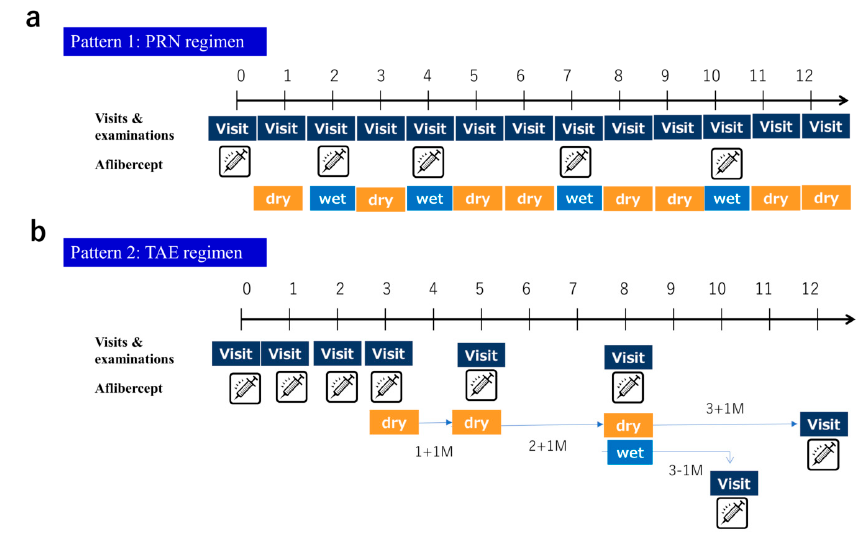
Figure 2. Example of the administration method of the pro re nata (PRN) and TAE regimen compared with the modified TAE regimen. ( a ) This pattern shows the PRN regimen. This pattern increased the number of clinic visits. ( b ) This pattern shows the TAE regimen. This TAE regimen required a loading phase of three consecutive monthly